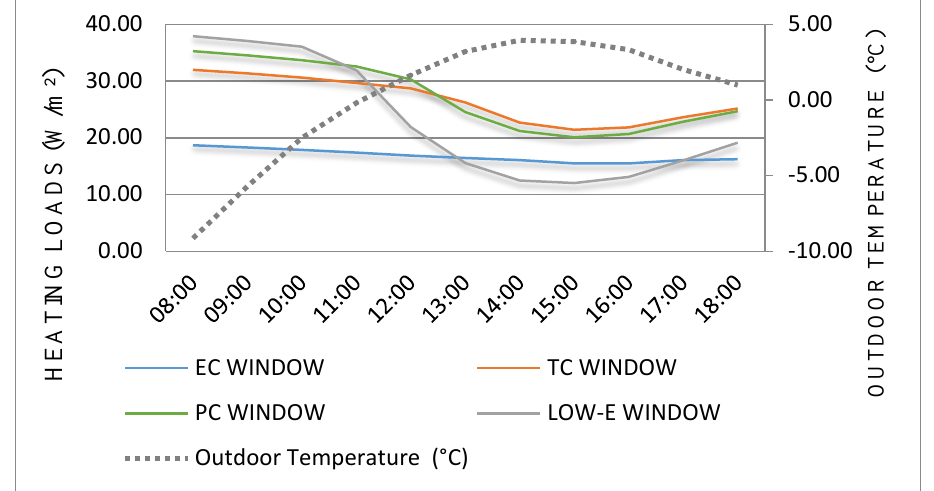
Figure 10 Heating loads of windows for February 12 in Kayseri.